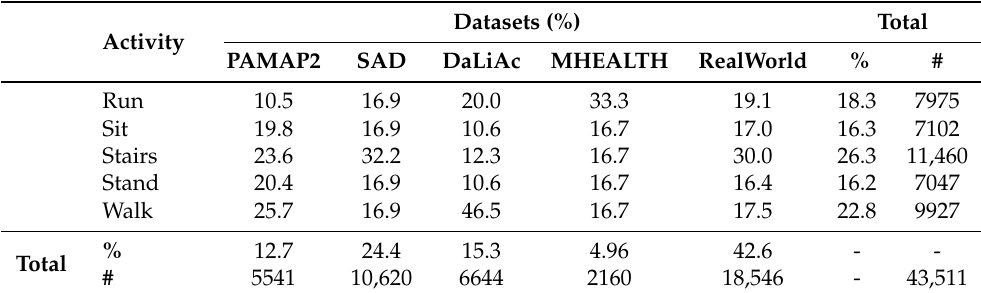
Table 2. Distribution of samples and activity labels per dataset. The # symbol represents the number of